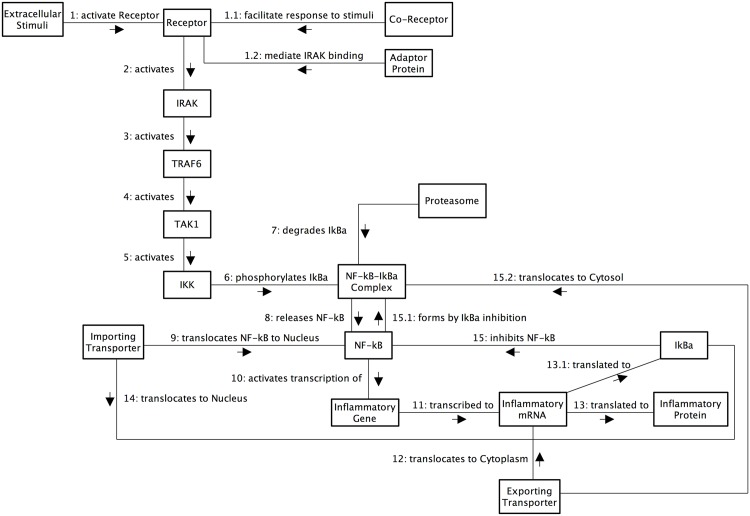
UML communication diagram.UML communication diagram for the IL-1 stimulated NF-κB signalling pathway. Although portraying temporal interactions as per sequence diagrams (not shown), we believe that these diagrams are more intuitive for non-Computer Science audiences as they are more flexible in relation to the position of system components, thus allowing the positioning of components to approximate to the spatial locations within a Eukaryotic cell. Developed from reviews of [56, 57].